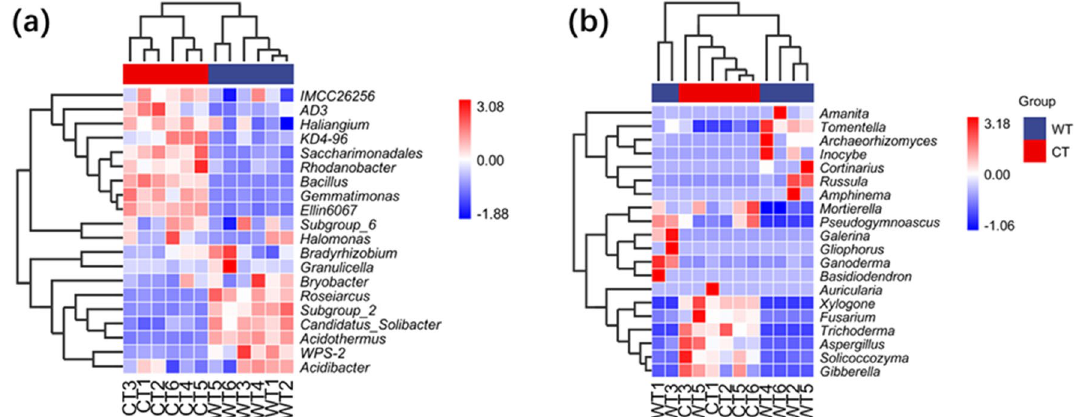
Figure 5. Hierarchical clustering heatmap of the relative abundance of the 20 most abundant ( a ) bacterial and ( b ) fungi genera, using Euclidean distance. Rows represent different samples, and the column shows the relative percentage of each microbial genus. The relative abundance of each bacterial genus is depicted by the color intensity in the figure below; CT = cultivated conditions, WT = wild conditions. Hierarchical clustering heatmap were created using the online program (https:// www. genes cloud. cn/ chart/ HeatM ap).